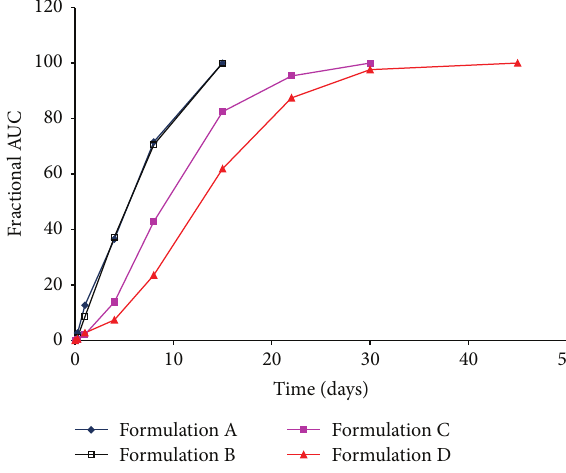
Figure 4: Fraction absorbed in vivo (Nelson-Wagner method).